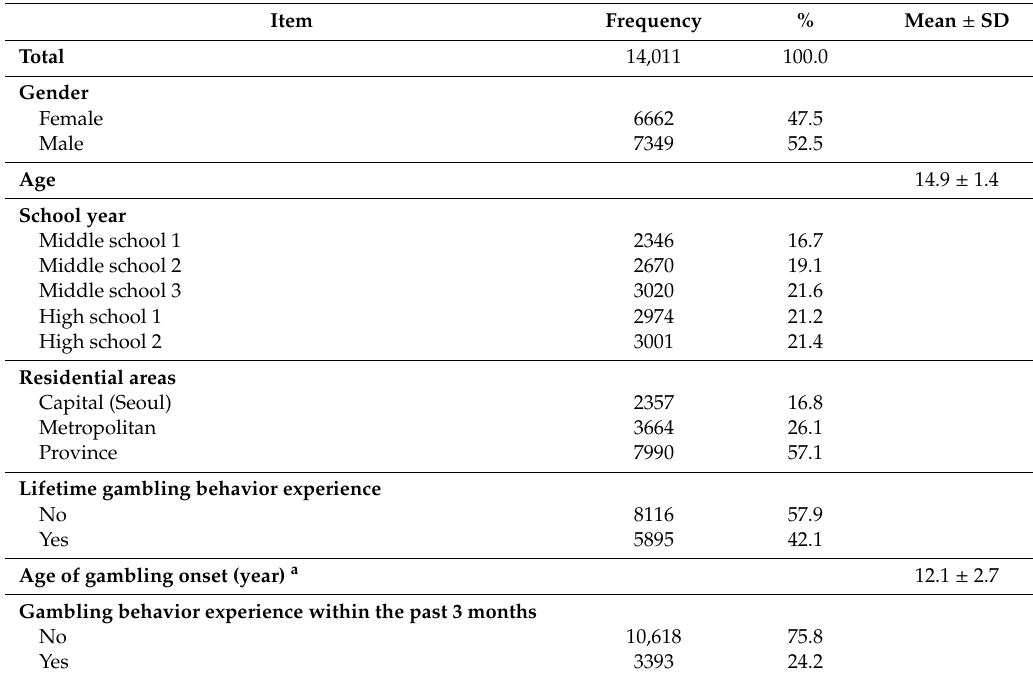
Table 1. General characteristics of the study